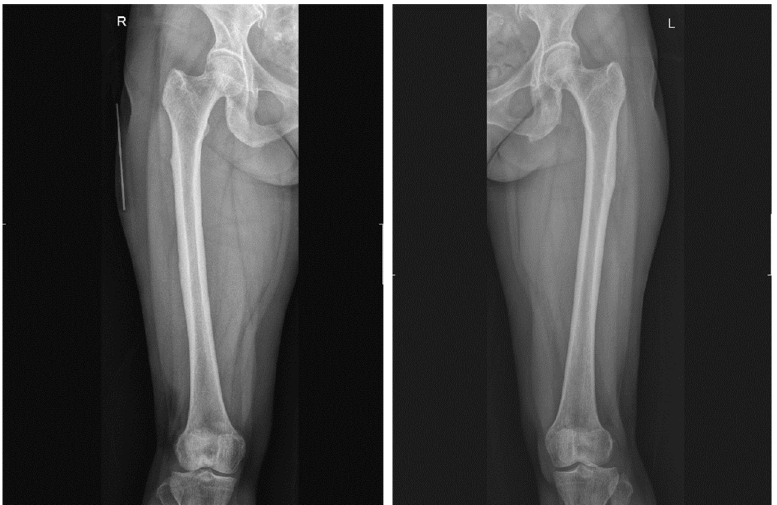
Figure 1. Anteroposterior X-ray of both femurs taken initially.